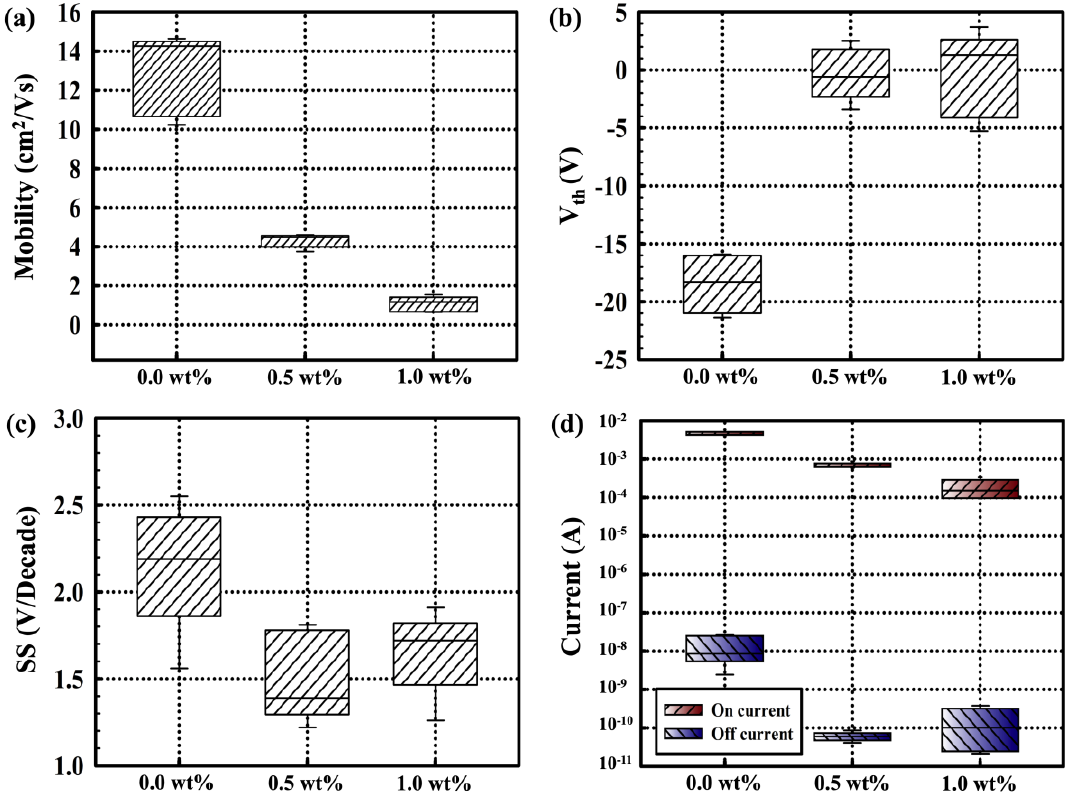
Figure 5. Extracted performance parameters of the fabricated Mg-doped SnO 2 thin film transistors: ( a ) field effect mobility in the saturation regime, ( b ) V th , ( c ) SS, and ( d ) I on and I off .